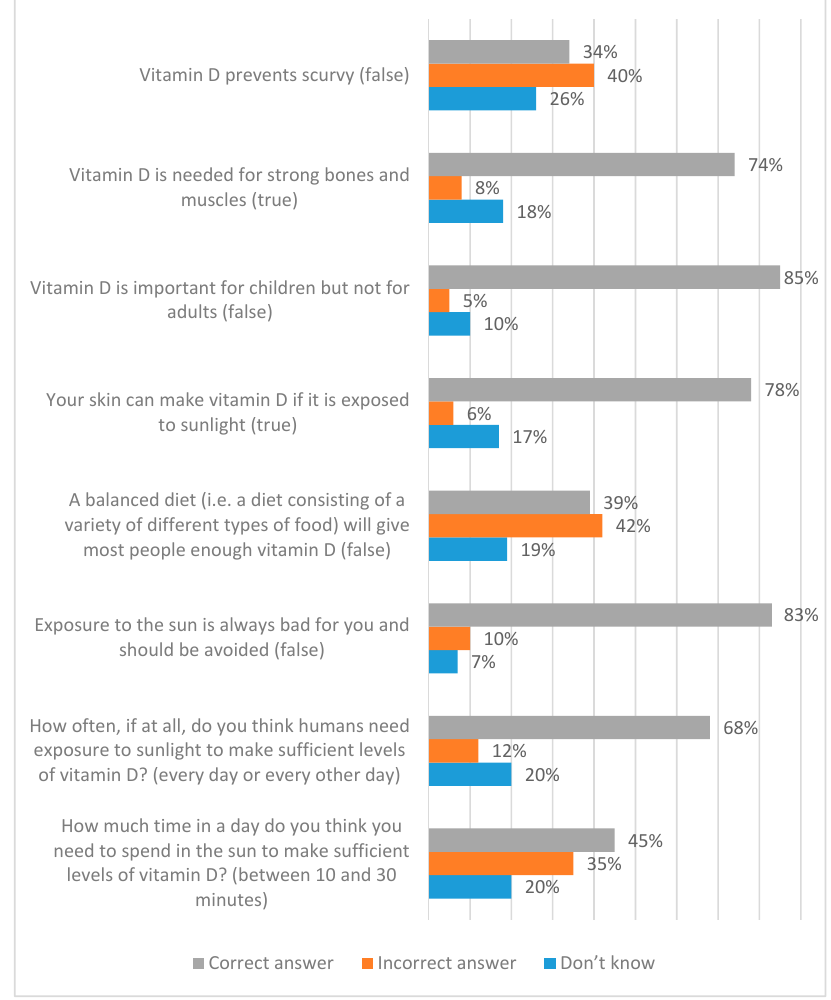
Figure 3. Public knowledge about vitamin D and sunlight exposure.